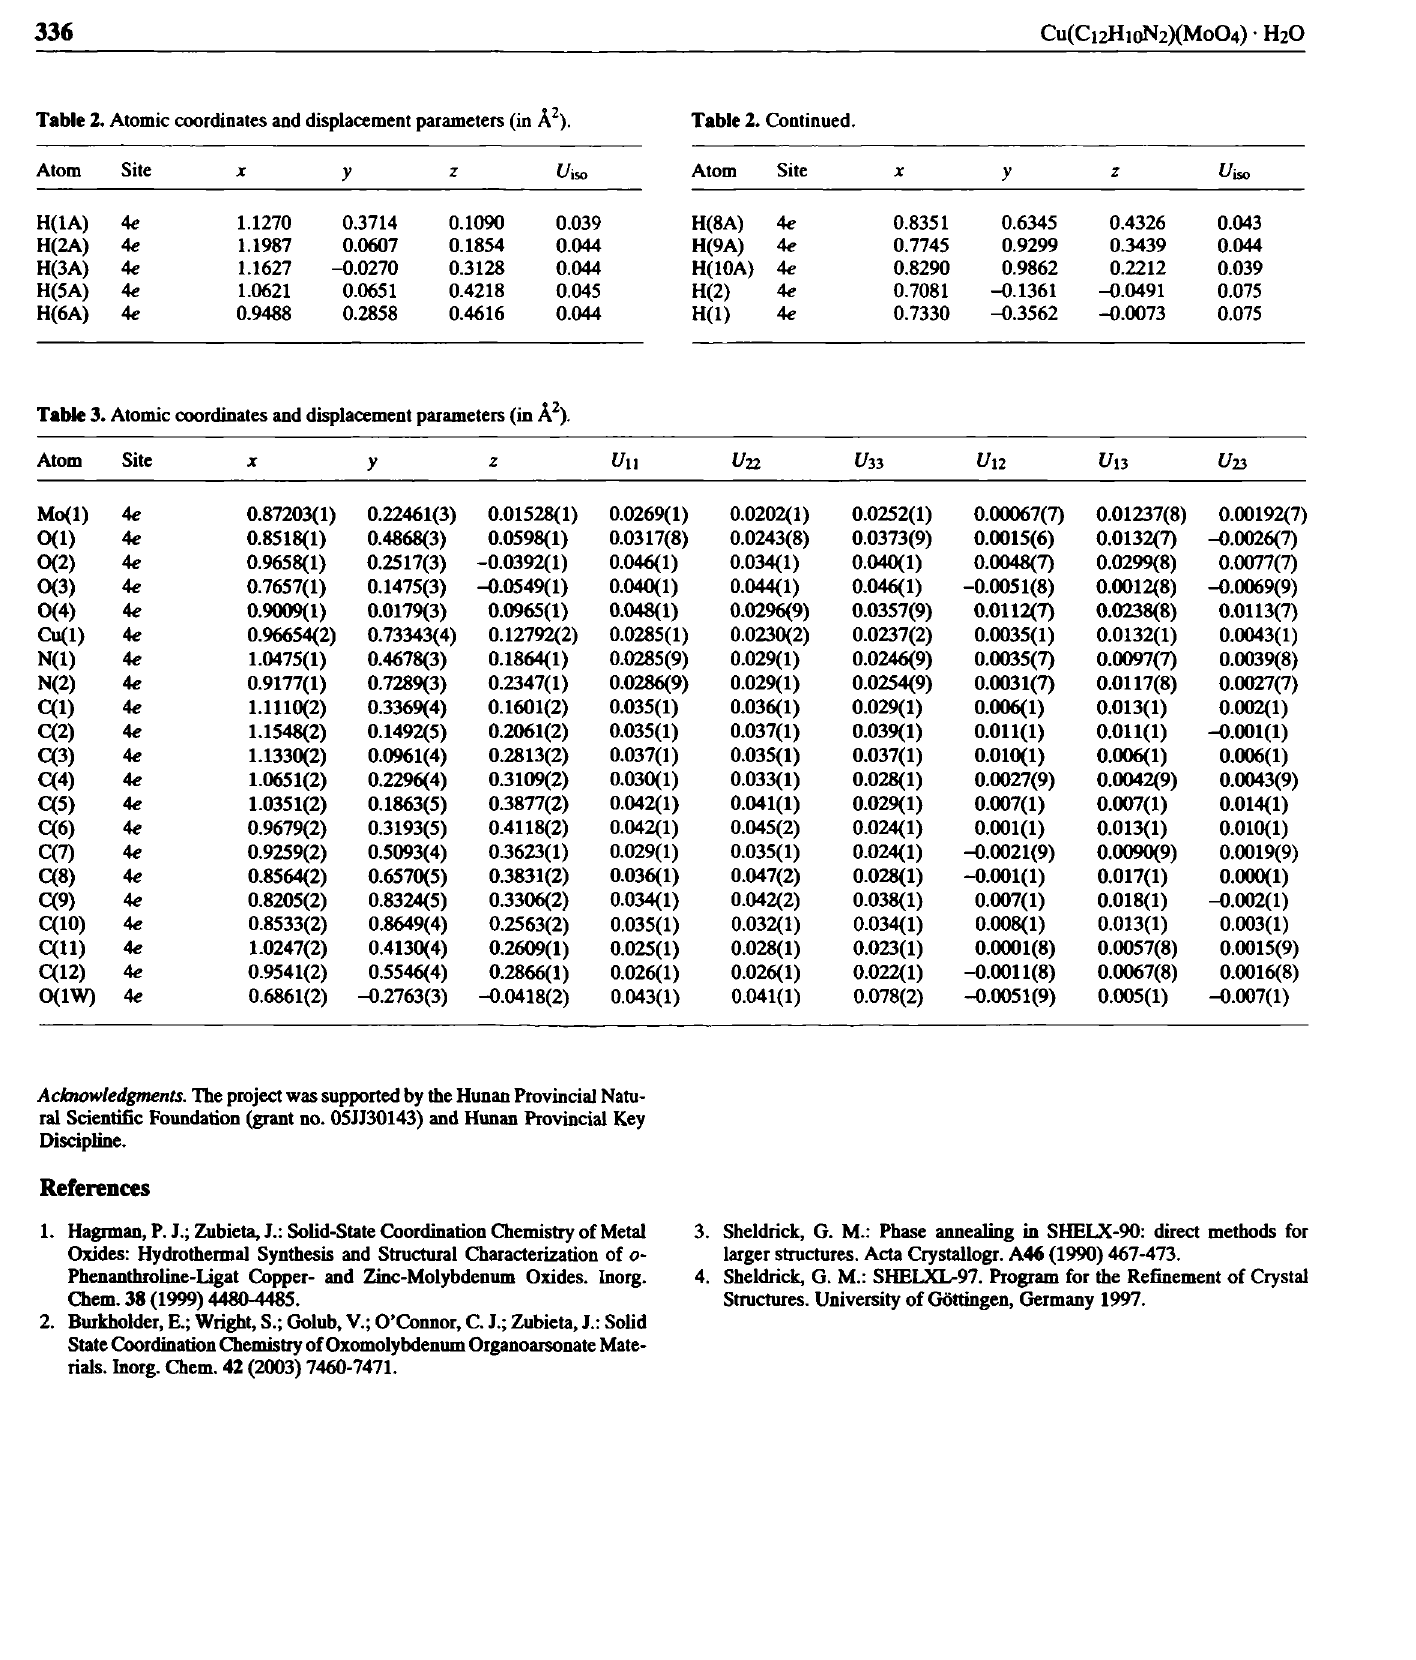
Table 2. Atomic coordinates and displacement parameters (in A 2 ).